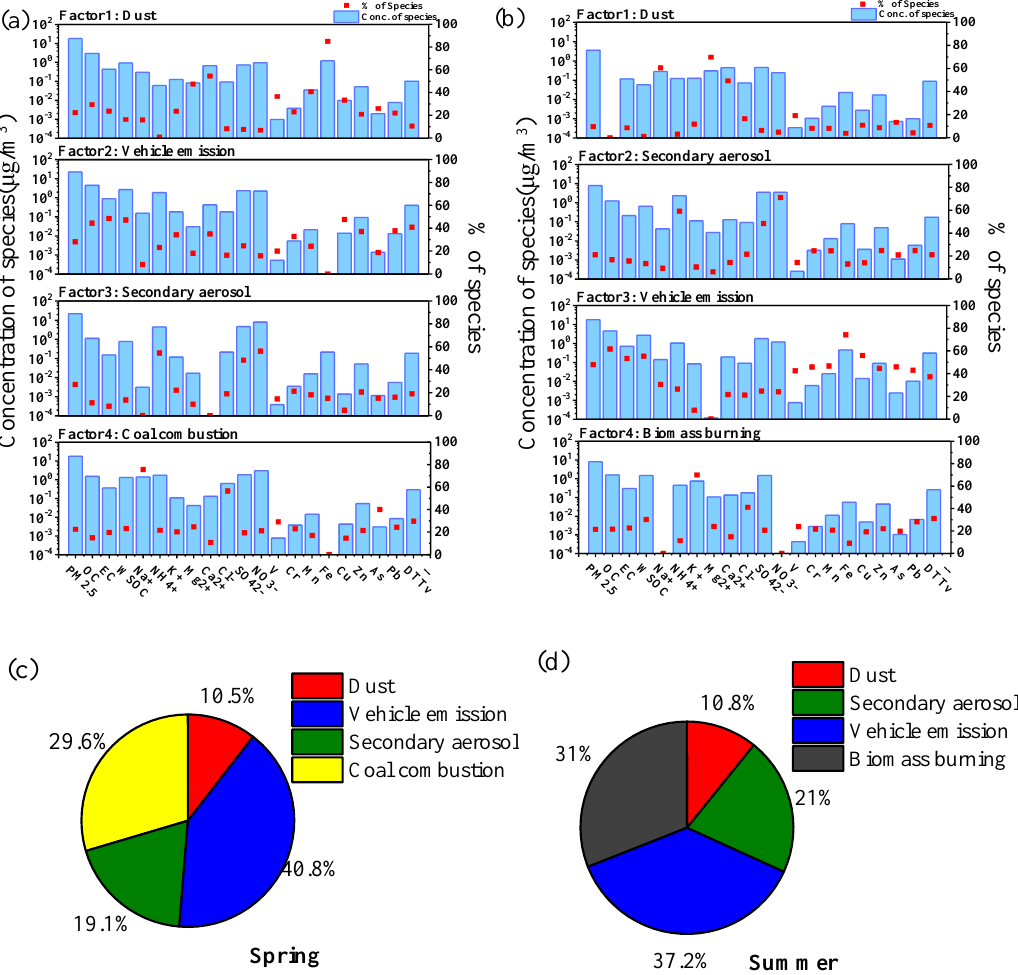
Figure 6. Profiles of four sources resolved by PMF model analysis in ( a ) spring and ( b ) summer, and calculated contributions of different PM 2.5 sources to DTT v in ( c ) spring and ( d ) summer.